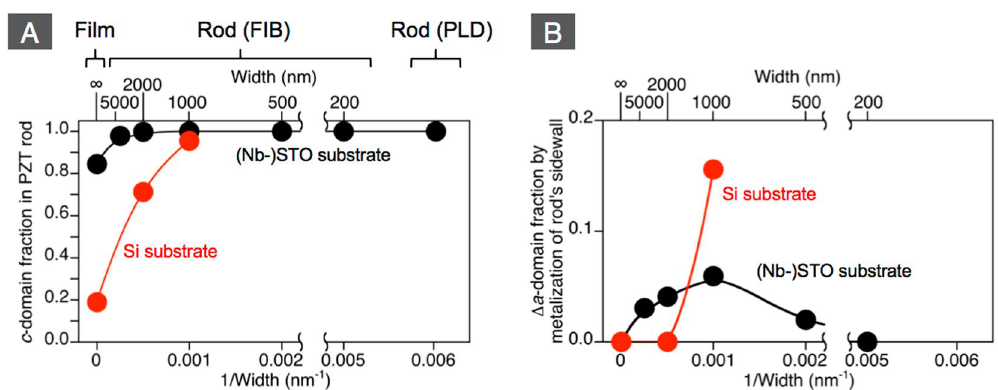
Figure 6. ( A ) c -domain fraction of PZT films and rods fabricated on LSCO/CeO 2 /YSZ-buffered on Si substrates and Nb-STO (or SrRuO 3 /STO) substrates as a function of the inverse rod width. The inverse rod width 0 represents the films. The fractions before the sidewall metallization by Pt are plotted. ( B ) increased amount of a -domain fraction by the sidewall metallization as a function of the inverse rod